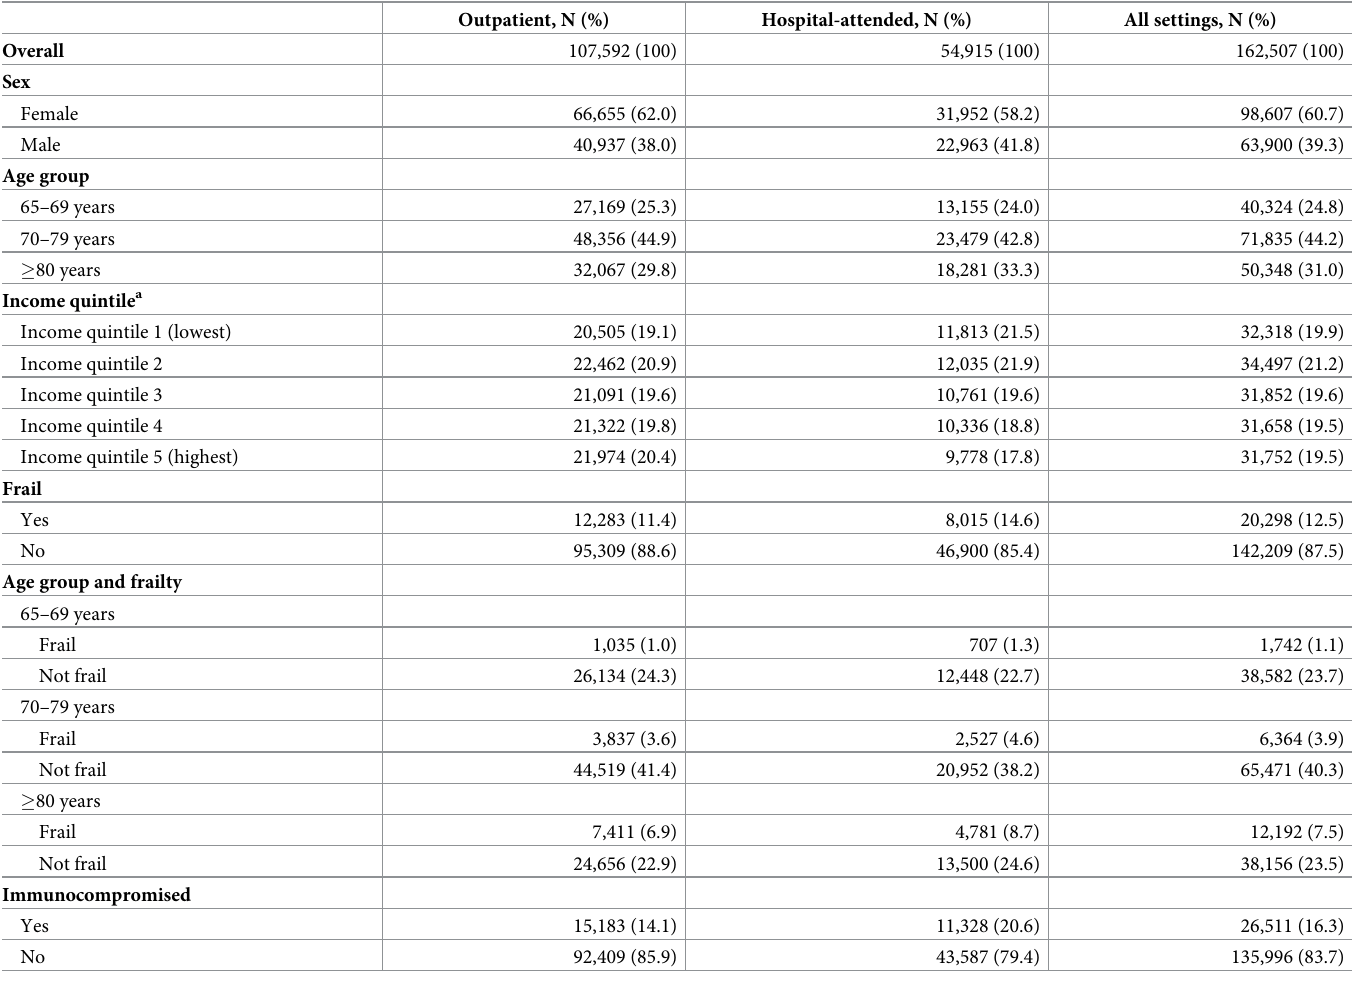
Table 1. Characteristics of herpes zoster cases by study